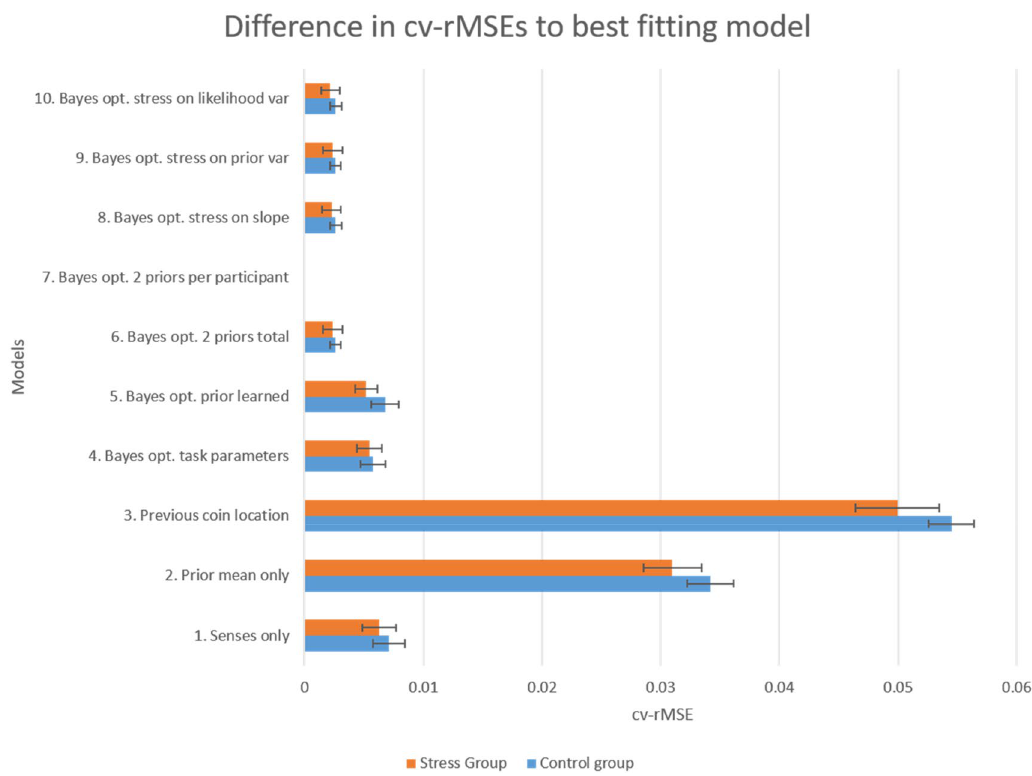
Figure 4. Model performance per group. Represented are the mean differences in the obtained cross-validated root mean squared errors (cv-RMSEs) between each model and the best performing model (here model 7), separated by group (see SI for details). Error bars represent the standard error of the